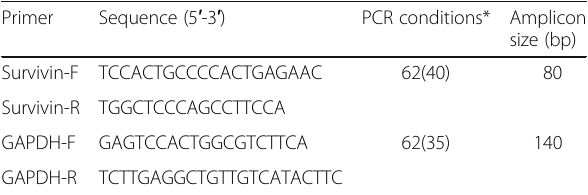
Table 1 List of oligonucleotides used in the present study Primer Sequence (5 ′ -3 ′ ) PCR conditions* Amplicon